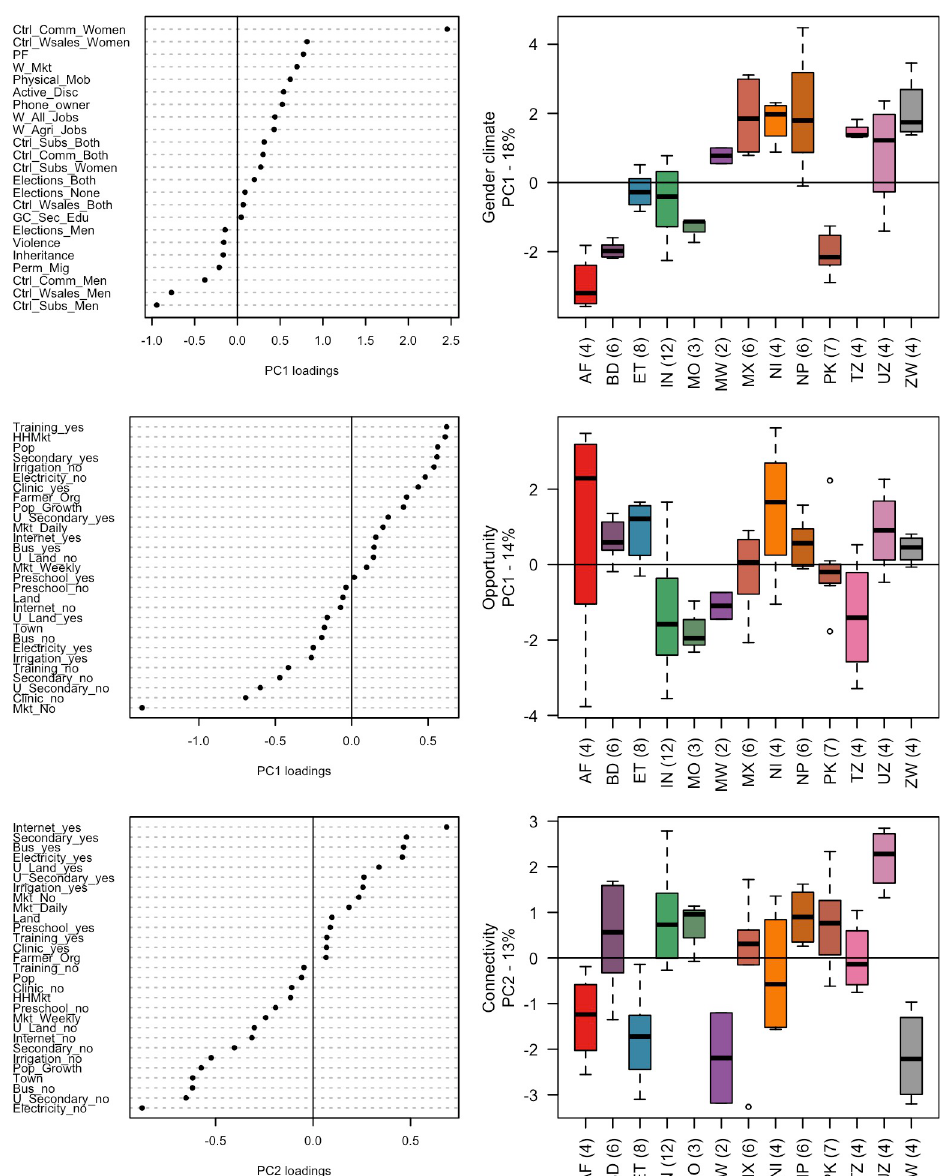
Fig 3. Loadings of variables and village scores according to ‘Gender climate’, ‘Opportunity’, and ‘Connectivity’. (A)The left column represents the loadings of the variables. (B) The right column represents the distribution of the village scores per country cohort (two letter code), the number of sampled villages per country cohort is shown in parentheses. The colour represents the different villages within country cohorts. (C) The first row is the ‘Gender climate’ component derived from 15 variables. (D) The second and third rows are the complementary components (‘Opportunity’ and ‘Connectivity’) derived from 17